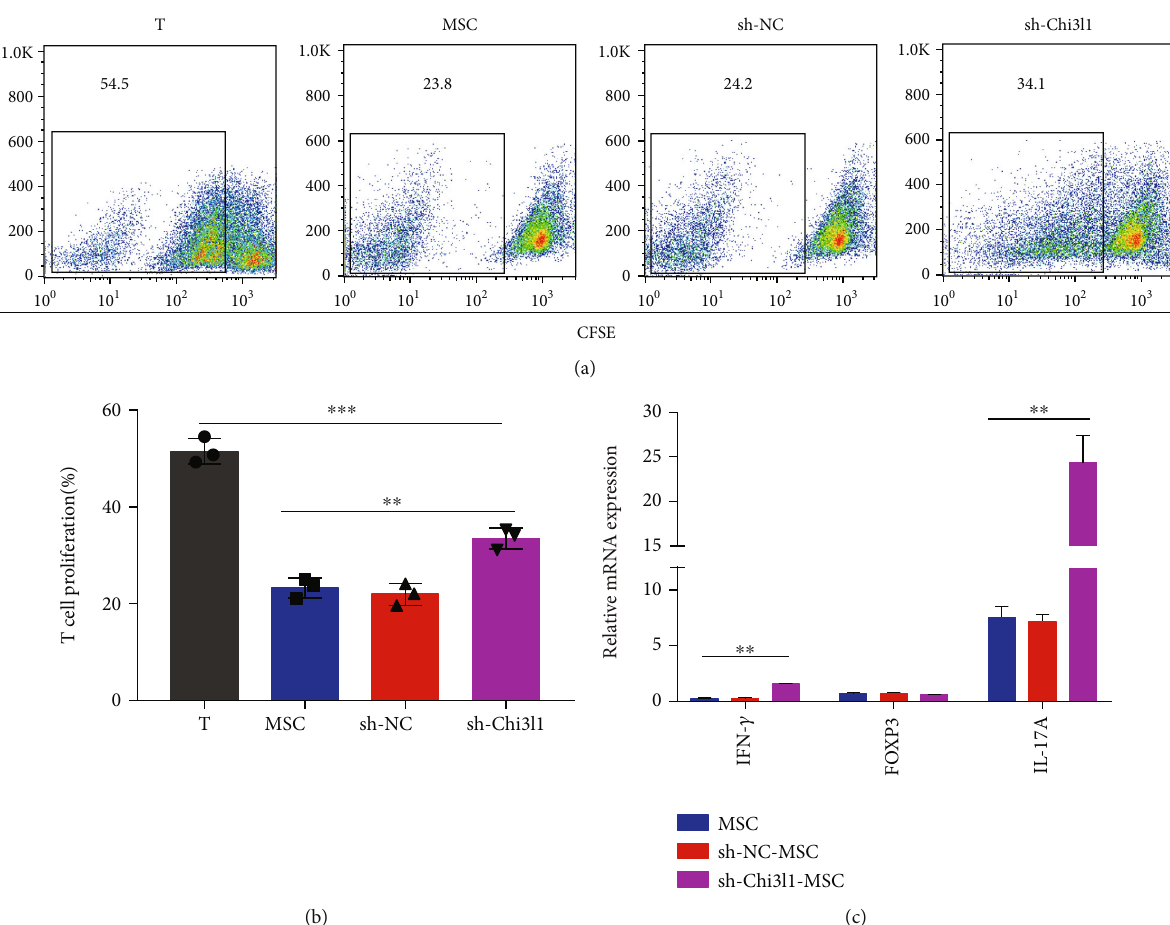
Figure 6: Chi3l1 deletion compromises hUC-MSCs and inhibits T cell proliferation. (a – c) CD3 + T cells obtained from the spleens of healthy C57BL/6J mice were stained with CFSE (5 μ M) and then incubated in 24-well plates with hUC-MSCs, sh-Chi3l1-MSCs, and sh-NC-MSCs at a CD3 + T/hUC-MSC ratio of 20:1 for 72 hours. (a) Proliferation of CD3 + T cells analyzed by fl ow cytometry. (b) CD3 + T cell proliferation was measured after treatment with di ff erent hUC-MSCs. (c) mRNA expression levels of IFN- γ , IL-17A, and FOXP3 analyzed by qPCR (three independent experiments, one-way ANOVA, and Tukey ’ s multiple comparison test, ∗∗ P < 0 : 01 ; ns: not signi fi